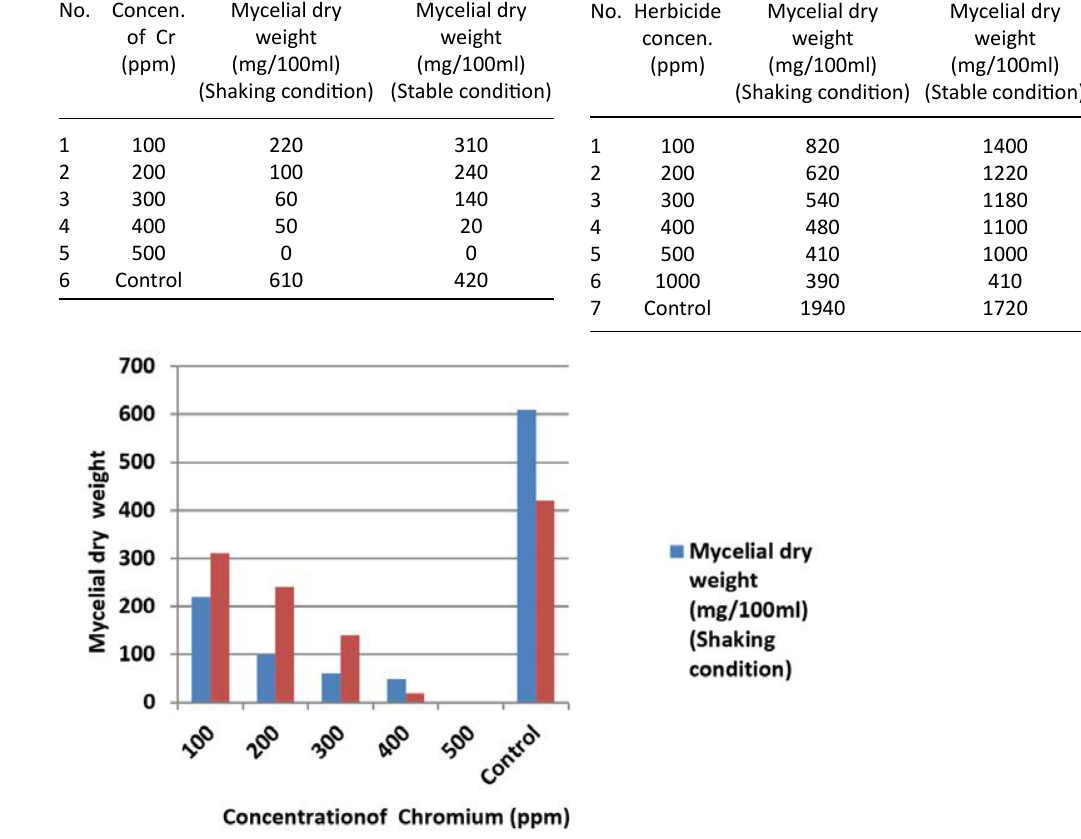
Fig. 5. Growth of A. terreus in chromium (Chromium III sulphate) amended medium in Shaking and stable culture